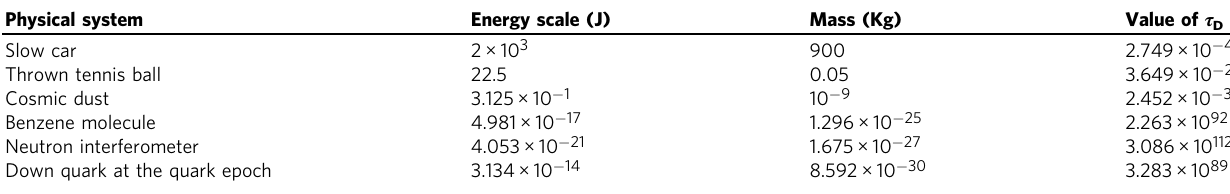
Table 1 Values of τ D for different physical systems.